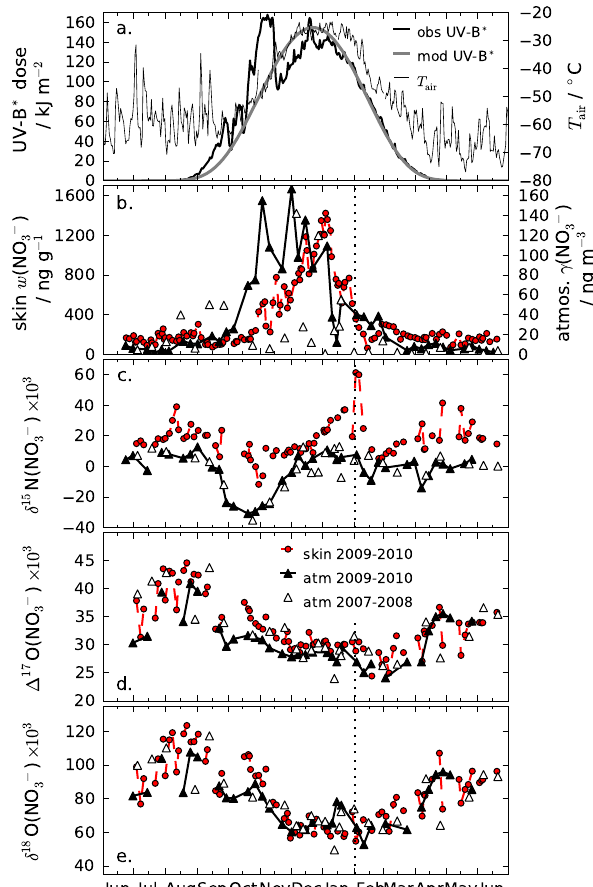
Fig. 6. DC atmospheric and skin layer NO − in 2007–2008 (Frey 3 et al., 2009) and 2009–2010 and skin layer nitrate in 2009–2010: (a) DC daily air temperature (thin line) and modelled UV-B ∗ (280– 320nm) for observed and a constant (290 DU) O 3 column density (black and grey lines) and a snow albedo of 0.9, (b) NO − concen- 3 ) , (d) 1 17 O ( NO − ) and (e) δ 18 O ( NO − ) in trations, (c) δ 15 N ( NO − 3 3 3 atmospheric nitrate in 2007–2008 and 2009–2010 (open and closed triangles, respectively) and in skin layer nitrate in 2009–2010 (red circles). The vertical dashed line shows the starting date of the